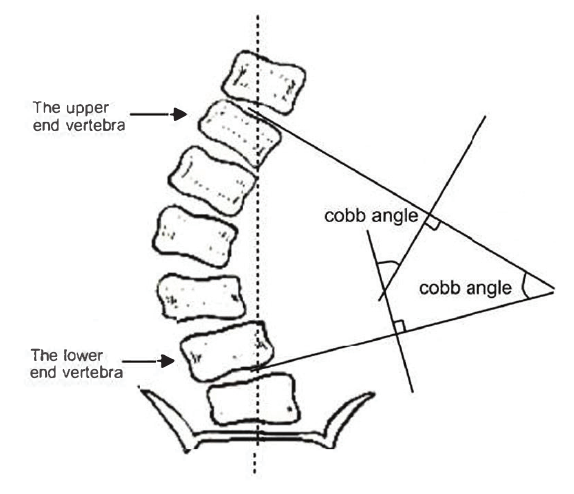
Figure 1. Definition of Cobb